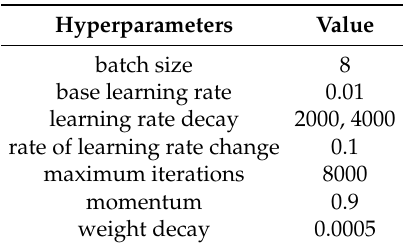
Table 2. Object detection network hyperparameter